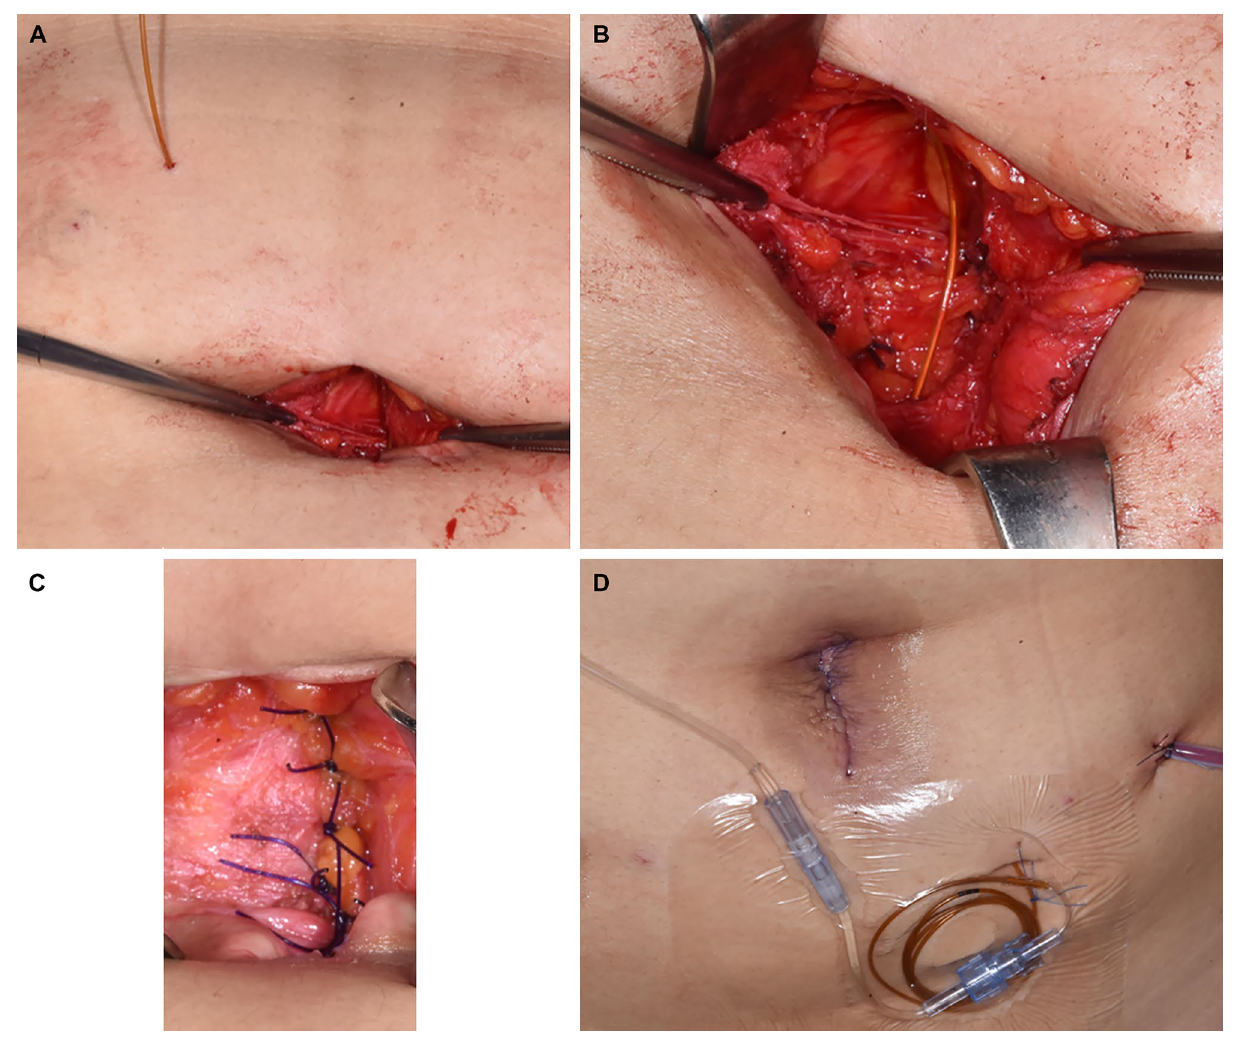
Figure 7. On-Q system